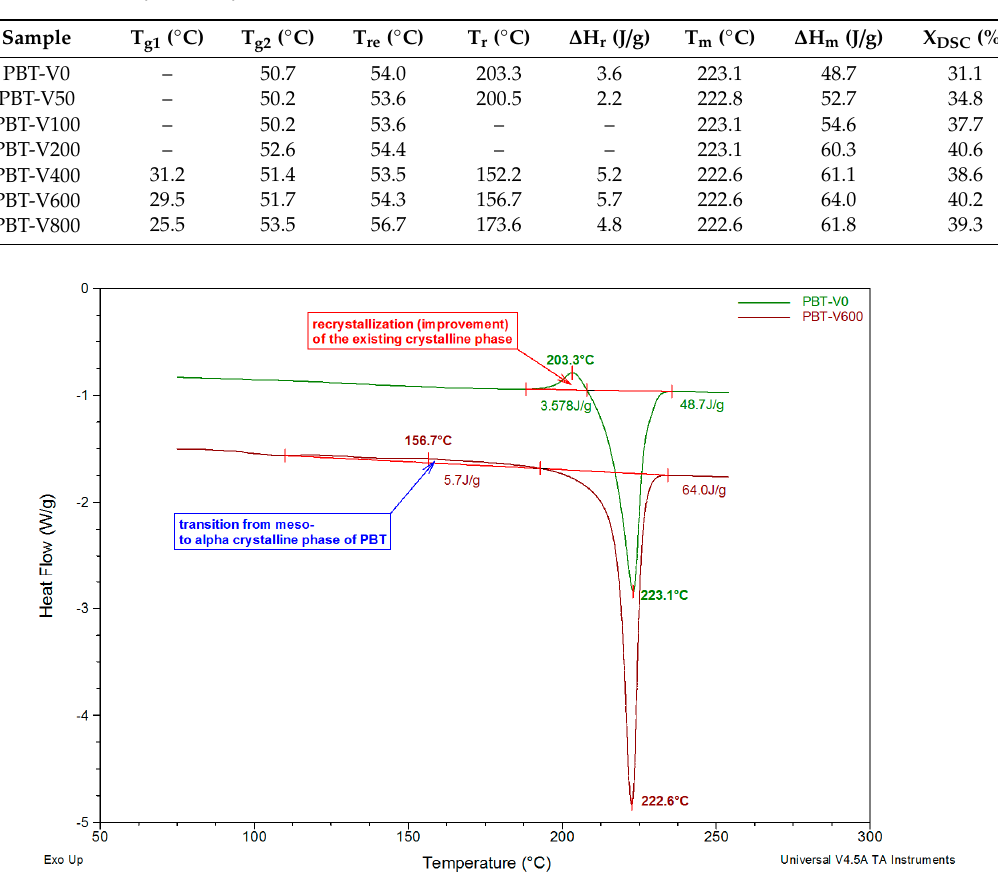
Figure 6. Illustration of the phase transitions that occur under the influence of heating: recrystallization within the existing PBT crystalline phase for fibers formed at take-up velocities from 0 to 50 m / min; phase transition of the smectic phase to the α -form for fibers formed at a take-up velocity above 400 m / min.